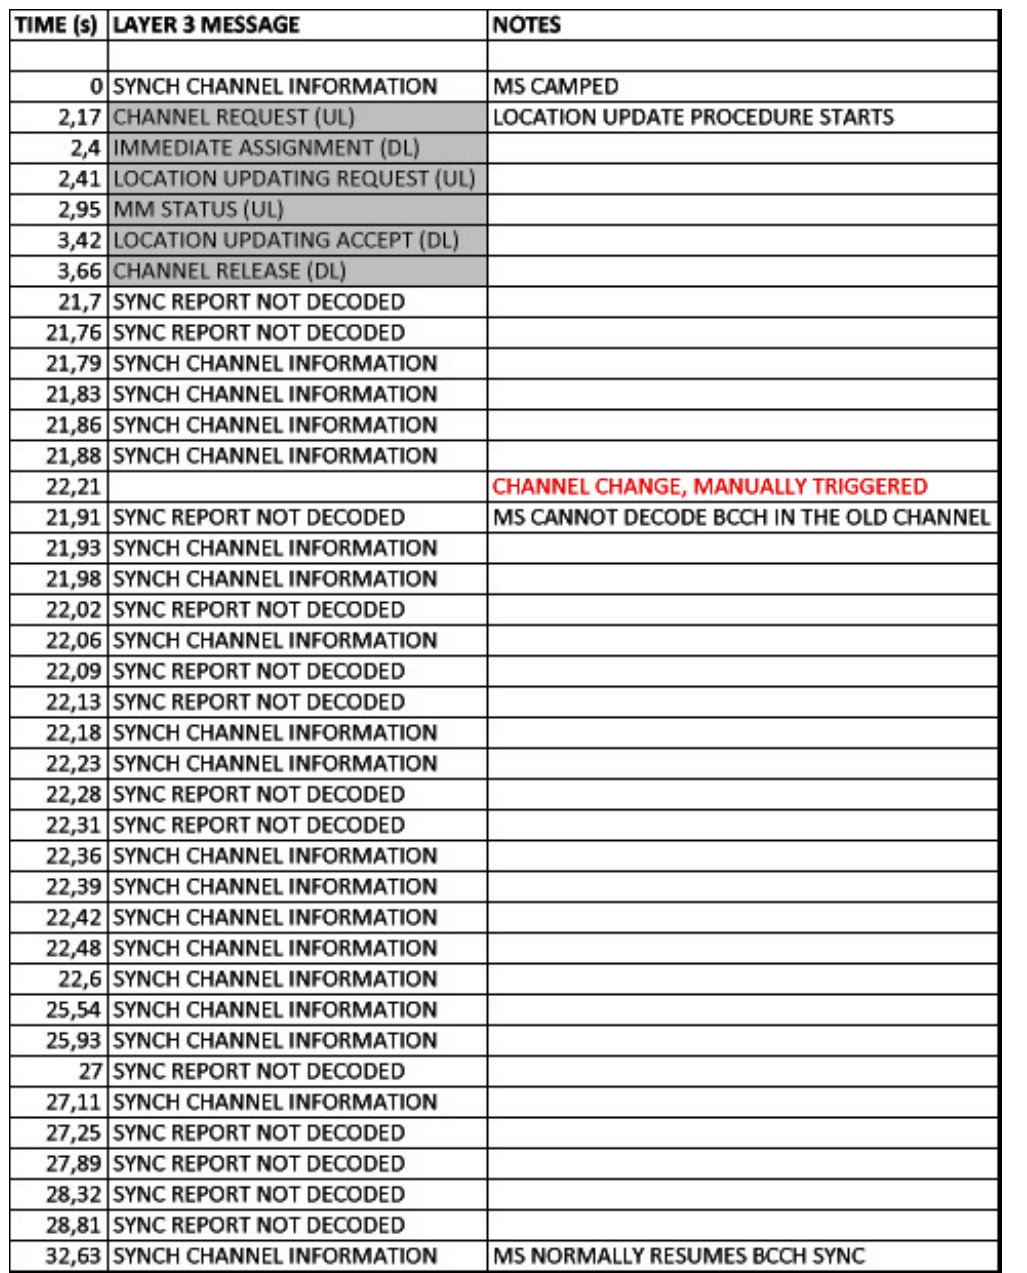
Figure 10. Idle mode—Normal cell reselection, Location Update procedure